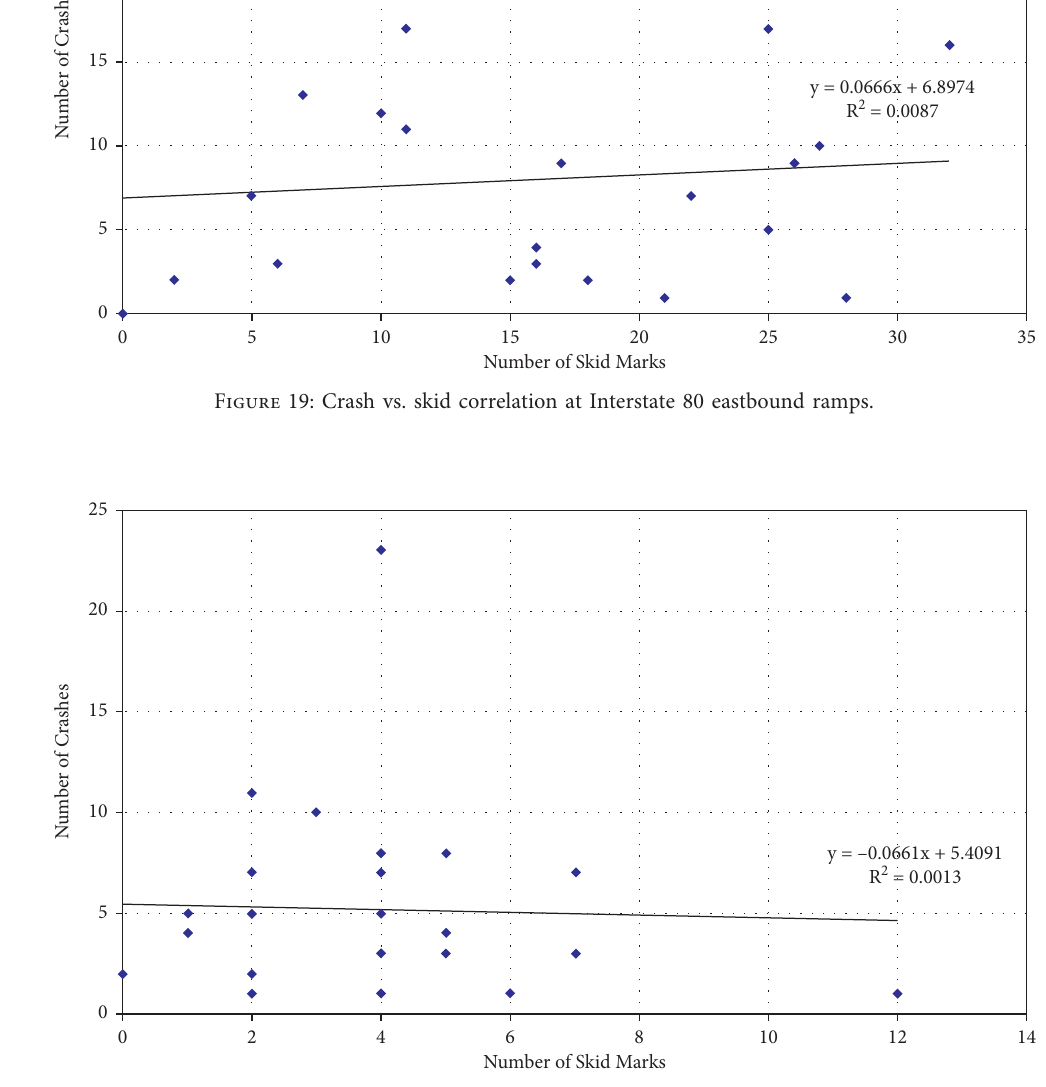
Figure 20: Crash vs. skid correlation at Interstate 80 westbound